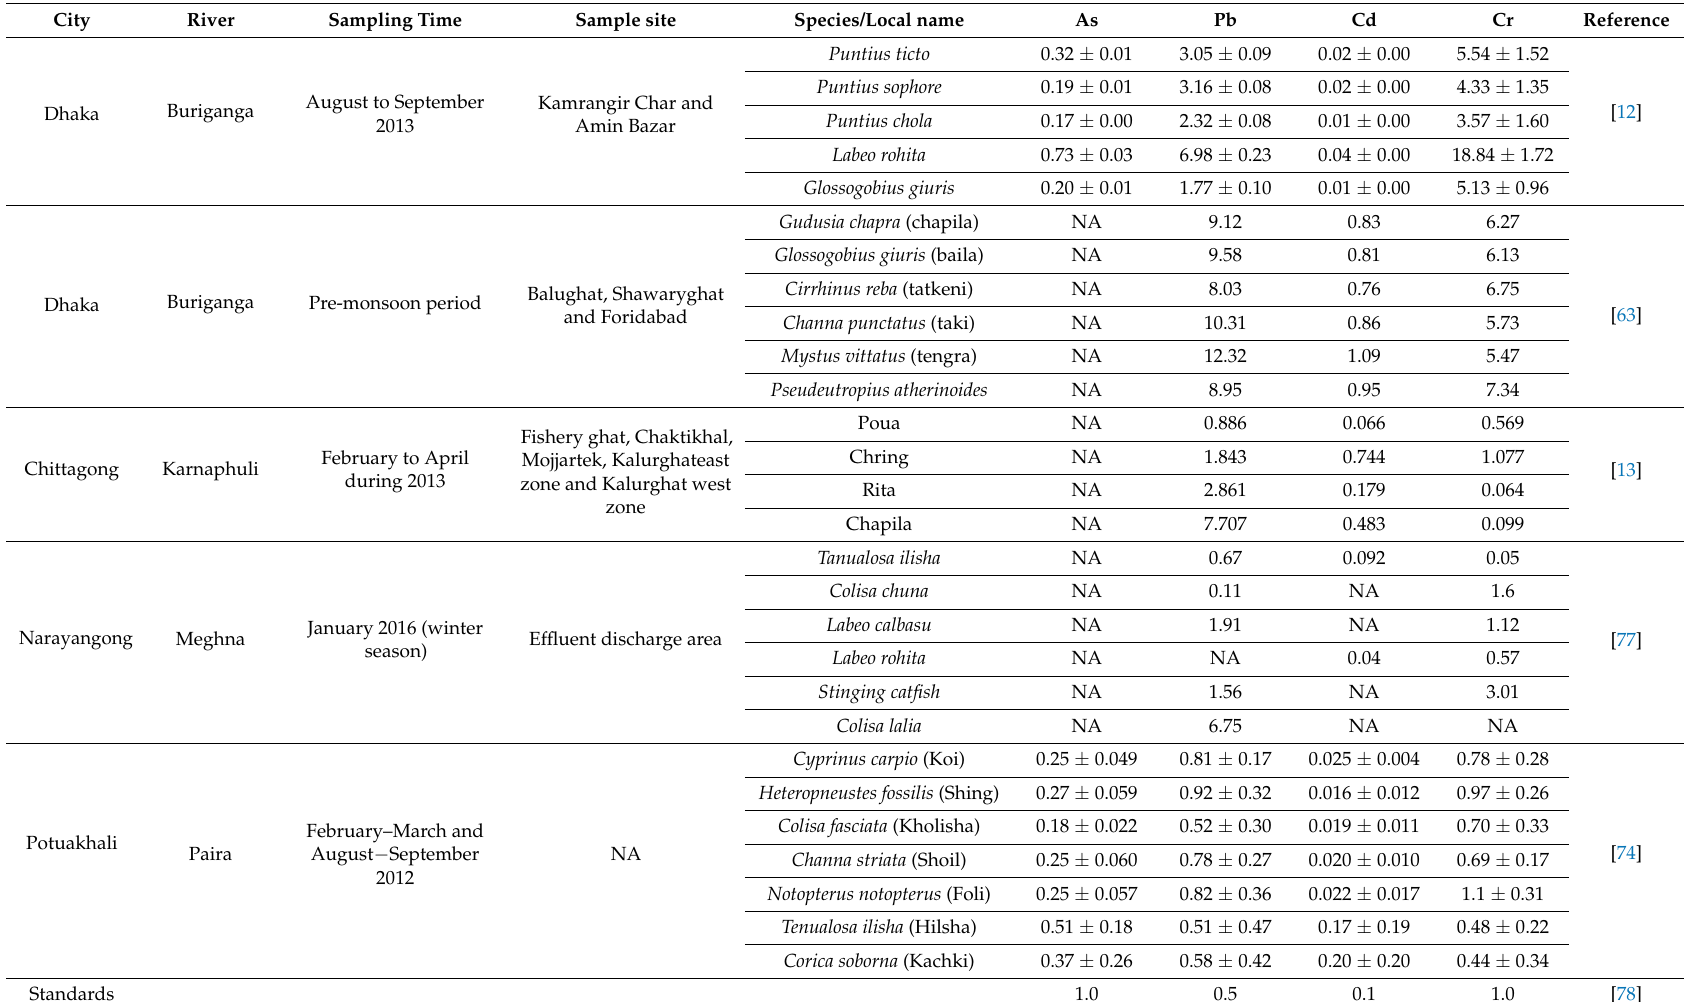
Table 4. Heavy metal and metalloid pollution of fishes from Bangladesh rivers